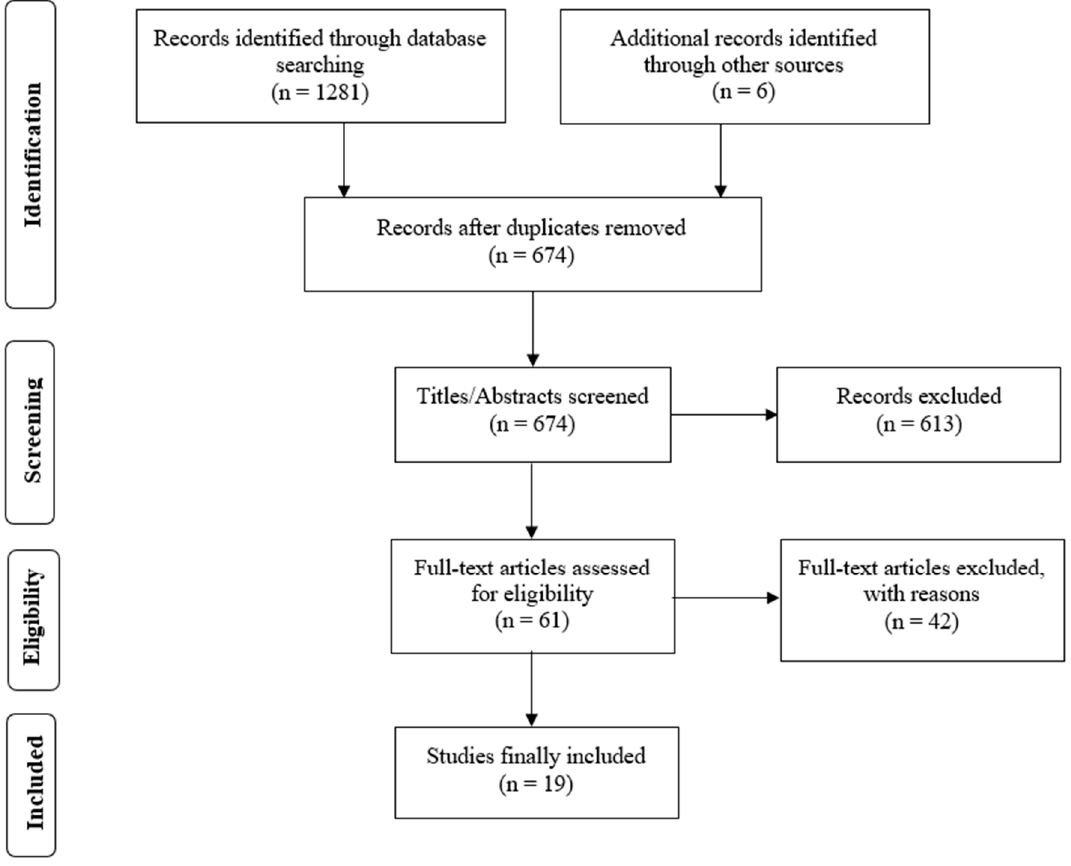
Figure1. Figure 1. Preferred Reporting Items for Systematic Reviews and Meta-Analyses (PRISMA) flow diagram.